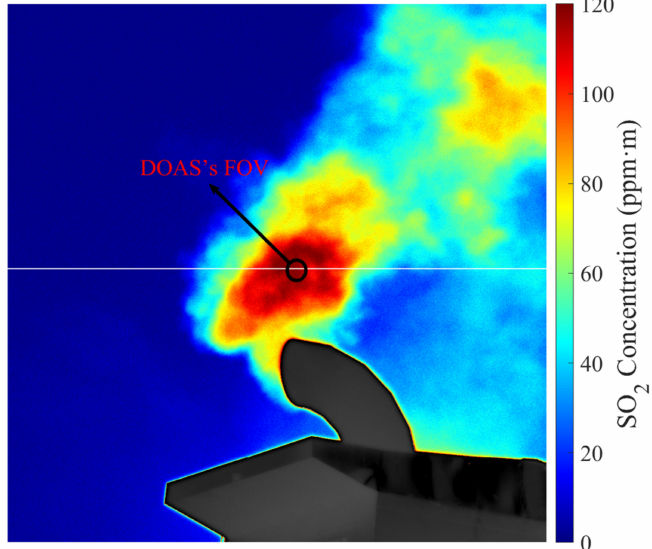
Figure 8. SO 2 concentration of the ship exhaust at 200 m retrieved by the UV camera. A row of pixels passing through the center of the plume is selected to calculate the detection limit of the camera (white line) and also marks the FOV of DOAS.